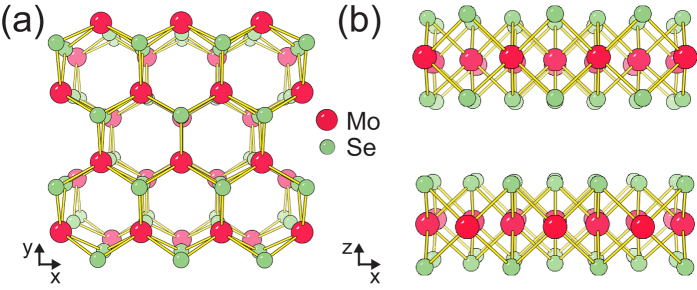
(a) Top view and (b) side view of 2H-MoSe2.